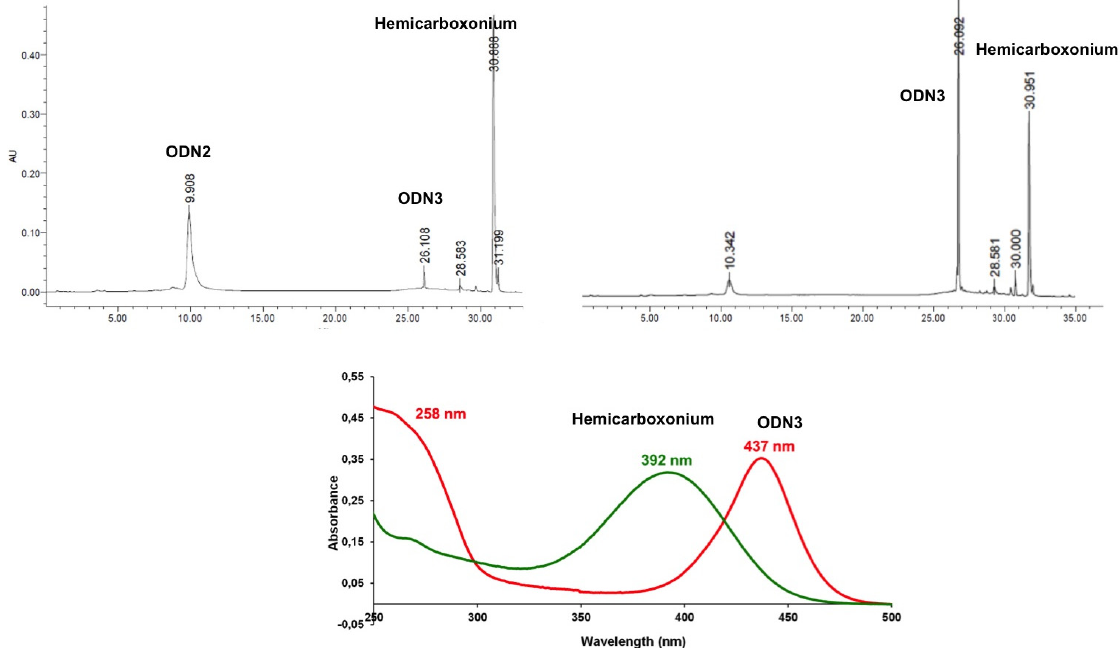
Figure 2. RP-HPLC monitoring of the reaction between ODN3 and Top left: RP-HPLC profile of the “click” formation of the conjugate ODN3 at t = 0, Top right: t = 1 h (X-Bridge OST C18 2.5 μ m, 4.6 × 50 mm, A: ACN; B: TEAA 50 mM, pH 7 from 5% of A to 80% in B. Bottom: UV spectra of Hemi1 (green) and of ODN3 (red) in pH 7 phosphate